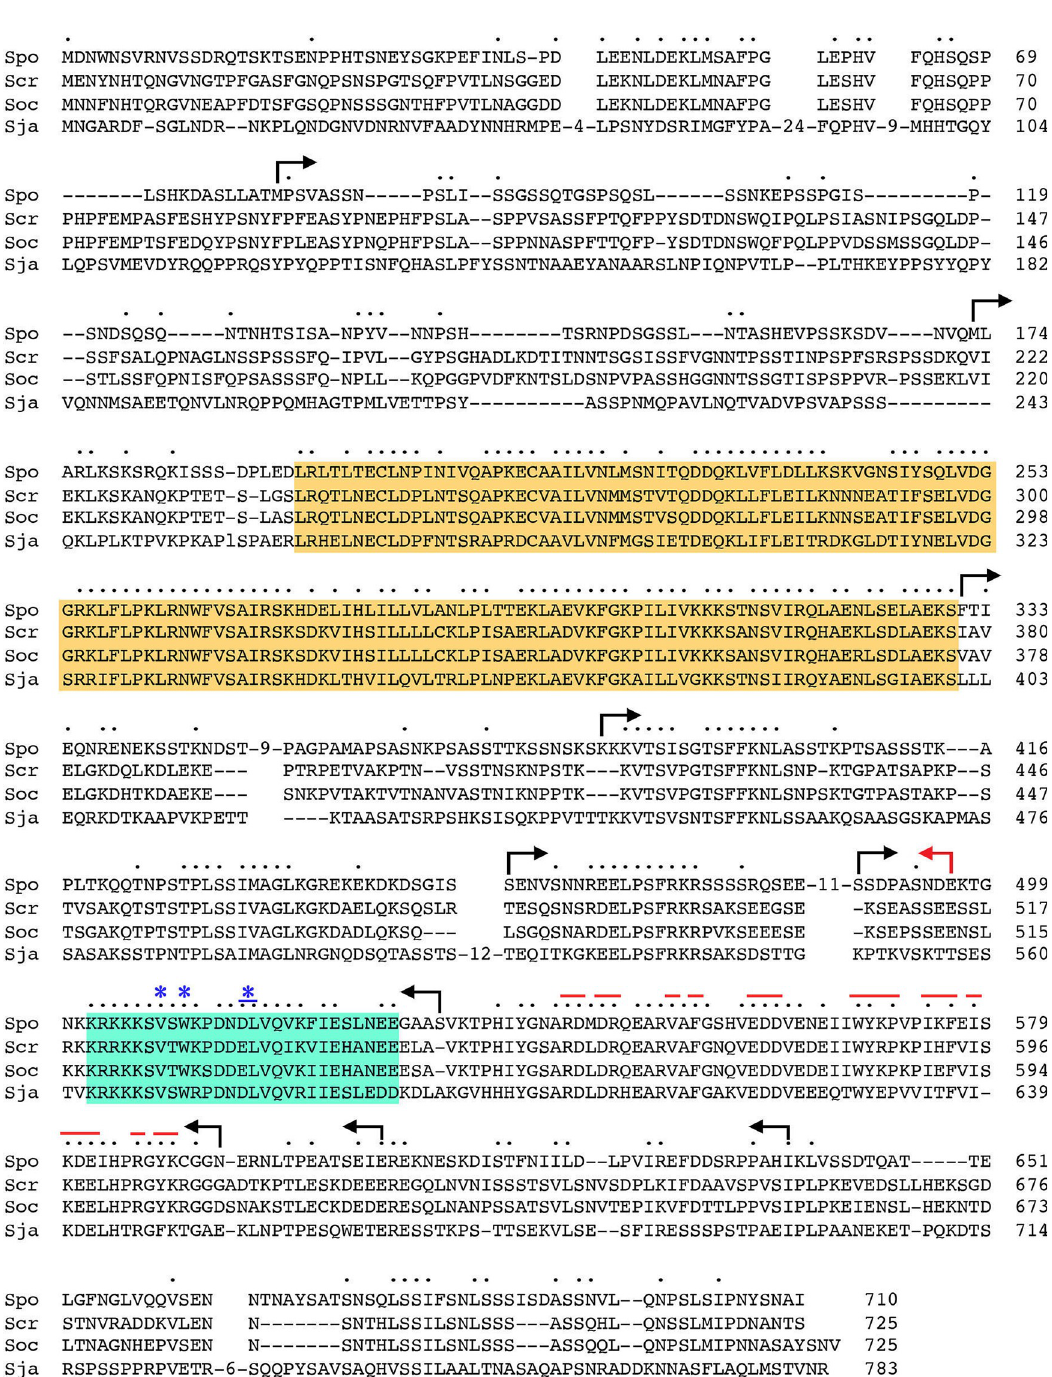
Fig 4. Primary structure of fission yeast Ppn1. The amino acid sequence of S . pombe (Spo) Ppn1 is aligned to those of the Ppn1 proteins from S . cryophilus (Scr), S . octosporus (Soc), and S . japonicus (Sja). Short gaps in the alignment are indicated by dashes; longer gaps are denoted by numbers of intervening amino acids. Positions of side chain identity/similarity in all four Ppn1 proteins are indicated by dots above the S . pombe sequence. Margins of serial N- and C-terminal truncations of S . pombe Ppn1 are shown as forward and reverse arrows. A conserved domain with predicted homology to the N-terminal TFIIS-like domain of rat PNUTS is highlighted in gold shading. A conserved segment that embraces the Dis2 binding site is highlighted in cyan shading; amino acids required for Ppn1-Dis2 interaction in a yeast 2-hybrid assay are denoted by asterisks above the alignment. The red lines above the alignment indicate residues within the Swd22 binding module of Ppn1 that were subjected to alanine scanning and testing of mutational effects on 2-hybrid protein-protein